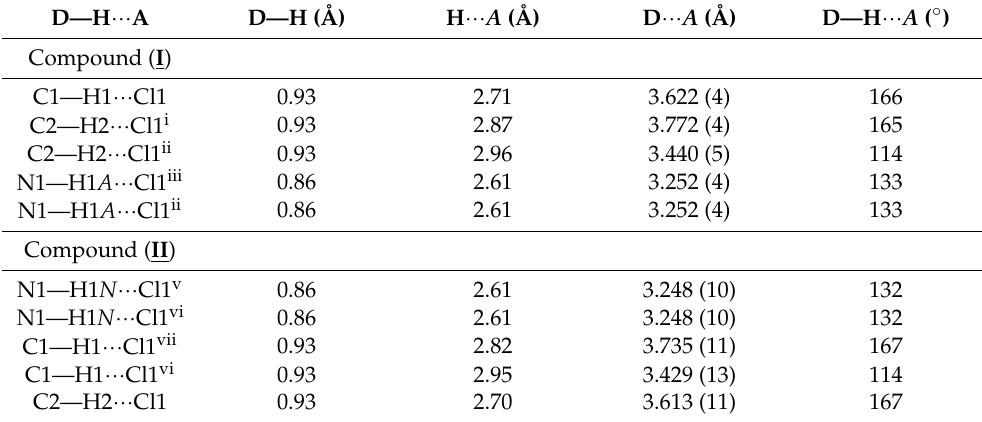
Table 2. H-bonds of compounds ( I ) and ( II ) (Å, ◦